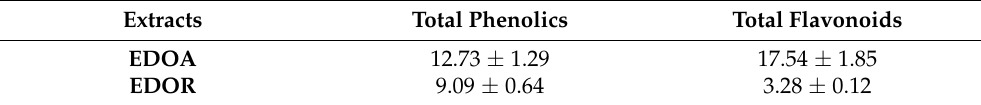
Table 3. The total phenolic ( µ gGAE/mL extract) and flavonoid ( µ gQE/mL extract) contents of ethanol extract of aerial parts (EDOA) and roots (EDOR) of sahlep ( D. osmanica ).